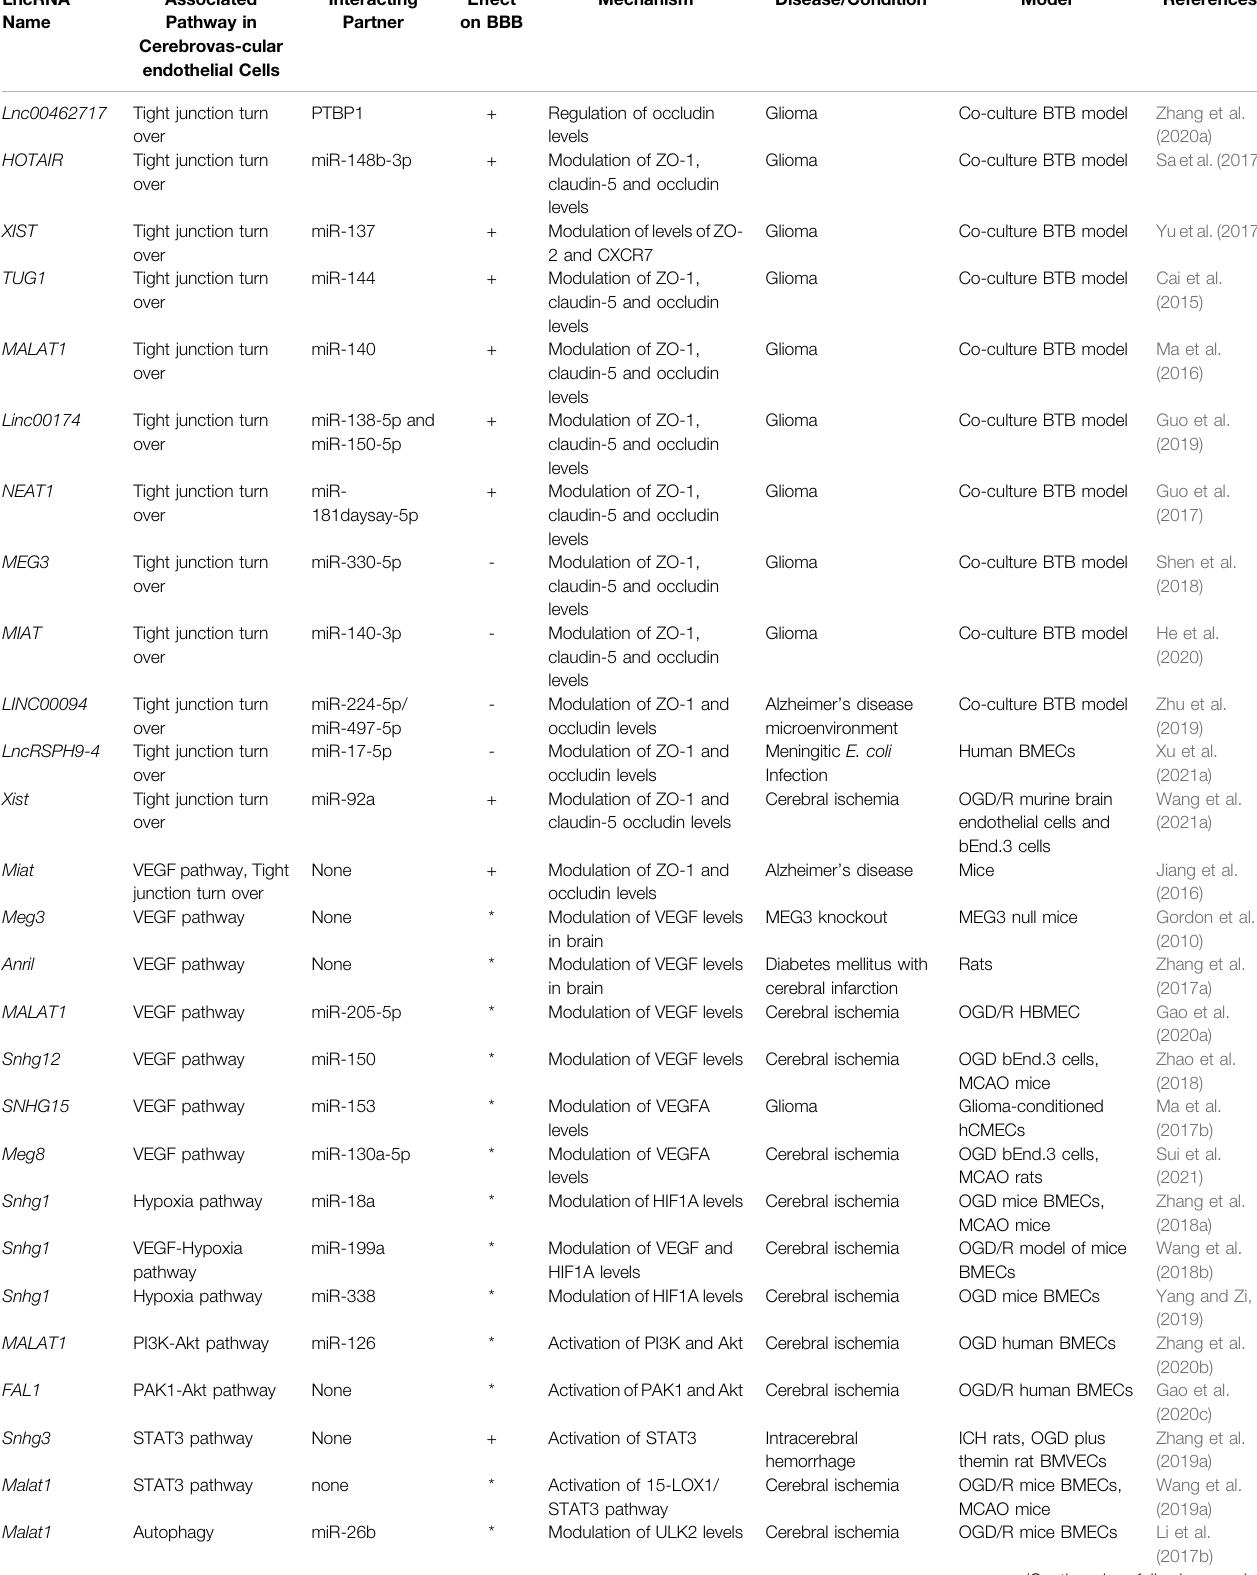
TABLE 1 | List of lncRNAs expressed in cerebrovascular endothelial cells and their functional roles. LncRNA